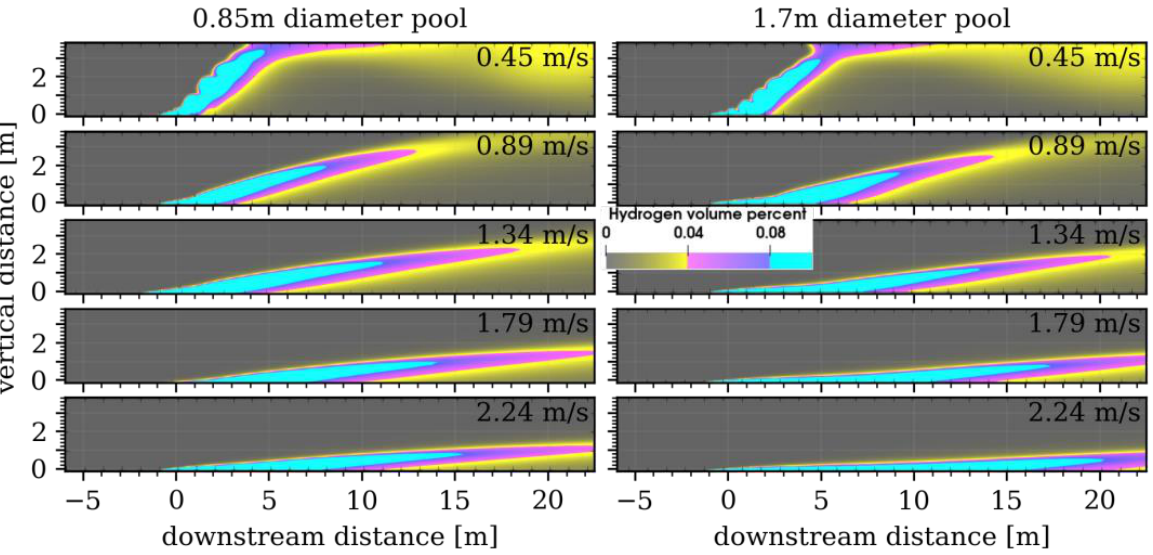
Figure 8. Profiles along the centerline of the shock tube for both diameter pools and all crosswind flow rates after the plume is at steady-state.